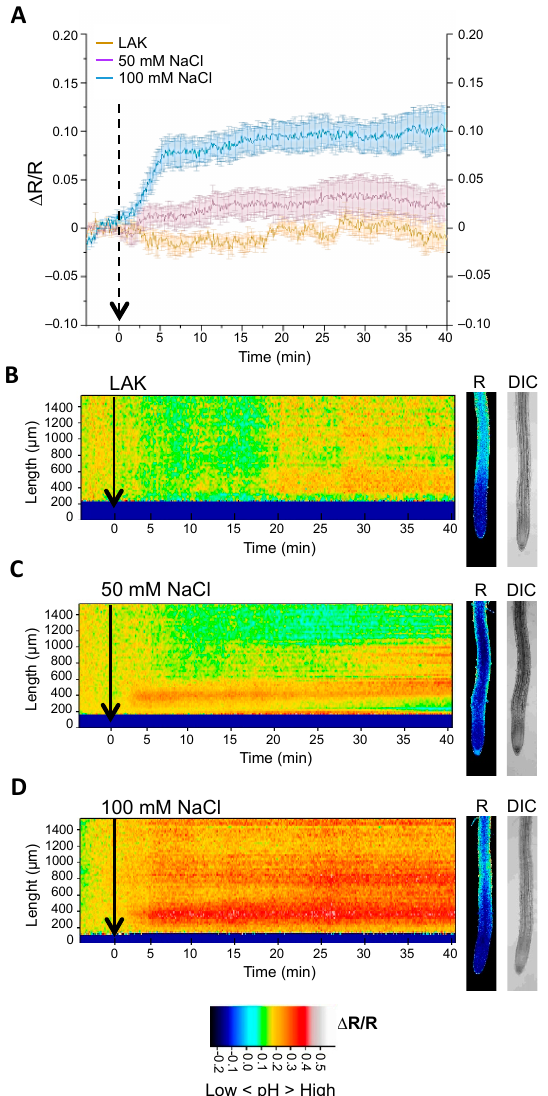
Figure 4. Cytosolic pH variations under salt stress near the vacuolar membrane. Seedlings of the Arabidopsis line expressing the pH sensor pHGFP-VTI11 were treated with either LAK medium 1 mM K + ( B ) or the same medium supplemented with 50 mM NaCl ( C ) or 100 mM NaCl ( D ). ( A ) Normalized emission ratio ( Δ R/R) changes of pHGFP-VTI11 with or without NaCl treatment; lines indicate the mean of emission ratio of the MEZ sector ± SEM from 5 to 6 seedlings. ( B , D ) Heat- maps of normalized data derived from 64 adjacent regions (268.2 × 24.2 µ m) according to the position scale on the left. On the right are shown fluorescence at time point 35 min and bright-field (DIC) images. Arrows indicate the beginning of the treatment. Heat-maps and roots pictures correspond to a representative experiment from 5 to 6 independent